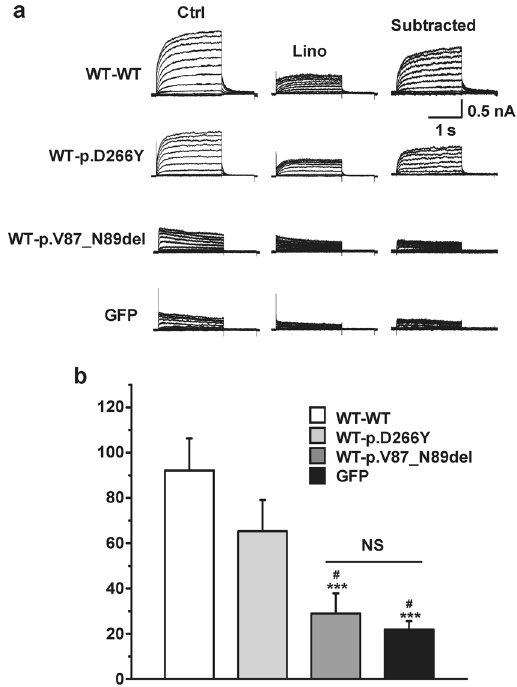
Figure 5. Potassium conductance of KCNQ4 channels assembled from tandem concatemers. ( a ) Representative K + current traces recorded from the KCNQ4 channels assembled from WT-WT, WT-p.D266Y, and WT-p. V87_N89del concatemers. GFP-transfected cells were used as controls, and linopirdine-sensitive currents were subtracted for comparison. ( b ) Comparison of current densities at + 40 mV. Means ± SEMs; WT-WT, n = 13; WT-p.D266Y, n = 12; WT-p.V87_N89del, n = 11; GFP, n = 6. NS, not significant; *** p < 0.005 versus WT-WT; #p < 0.05 versus